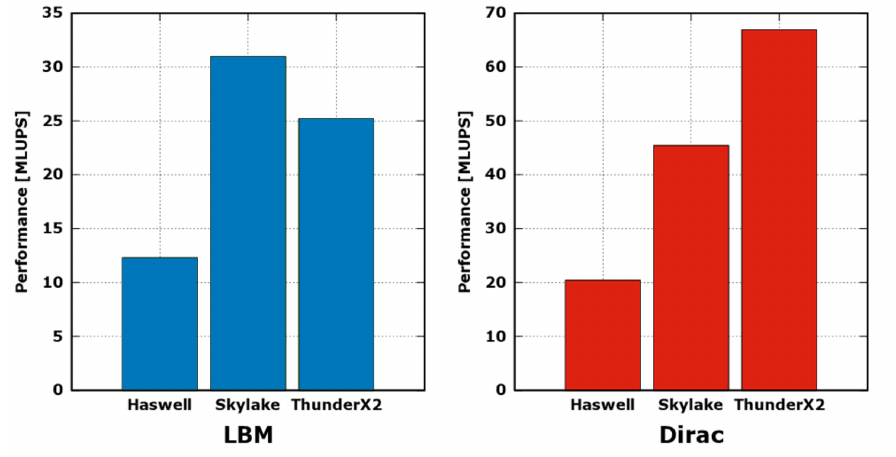
Figure 2. Performance in MLUPS (Mega Lattice-Updates per Second) of LBM and Dirac , run, respectively, on a lattice of 2048 × 8192 points, and 32 4 sites.